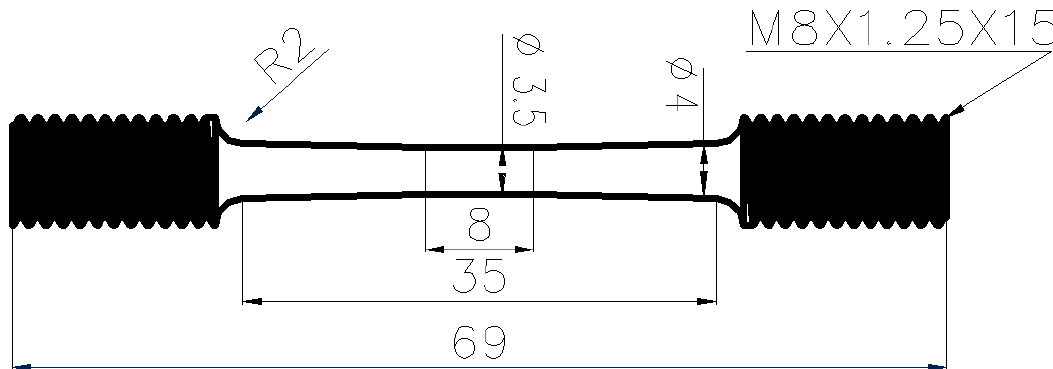
Figure 1. Dimension of test specimen (unit: mm).